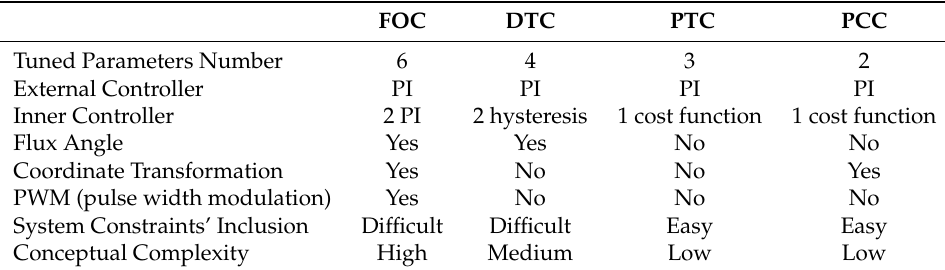
Table 1. Comparative issues in